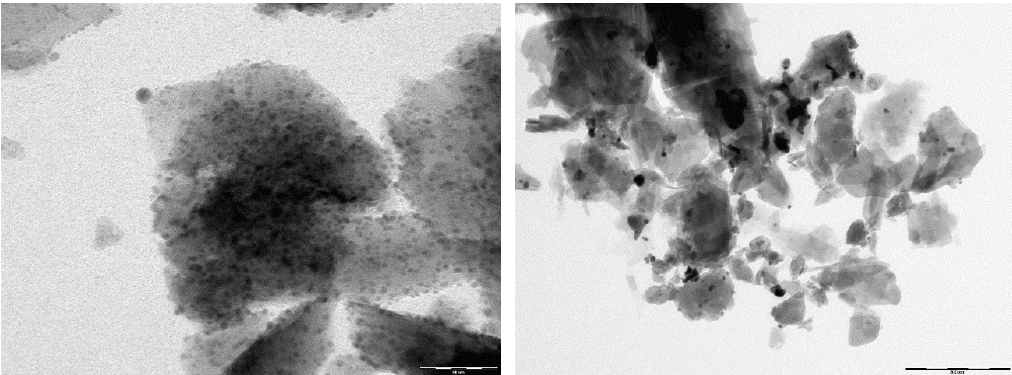
Figure 9. TEM images of Ag 2 O@NZU (( left ), scale 50 nm) and Ag 0 @NZU (( right ), scale 500 nm) samples.